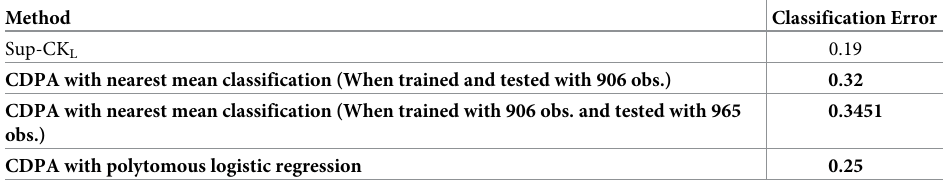
Table 5. Results for nearest neighbor classification for the extended Kahraman